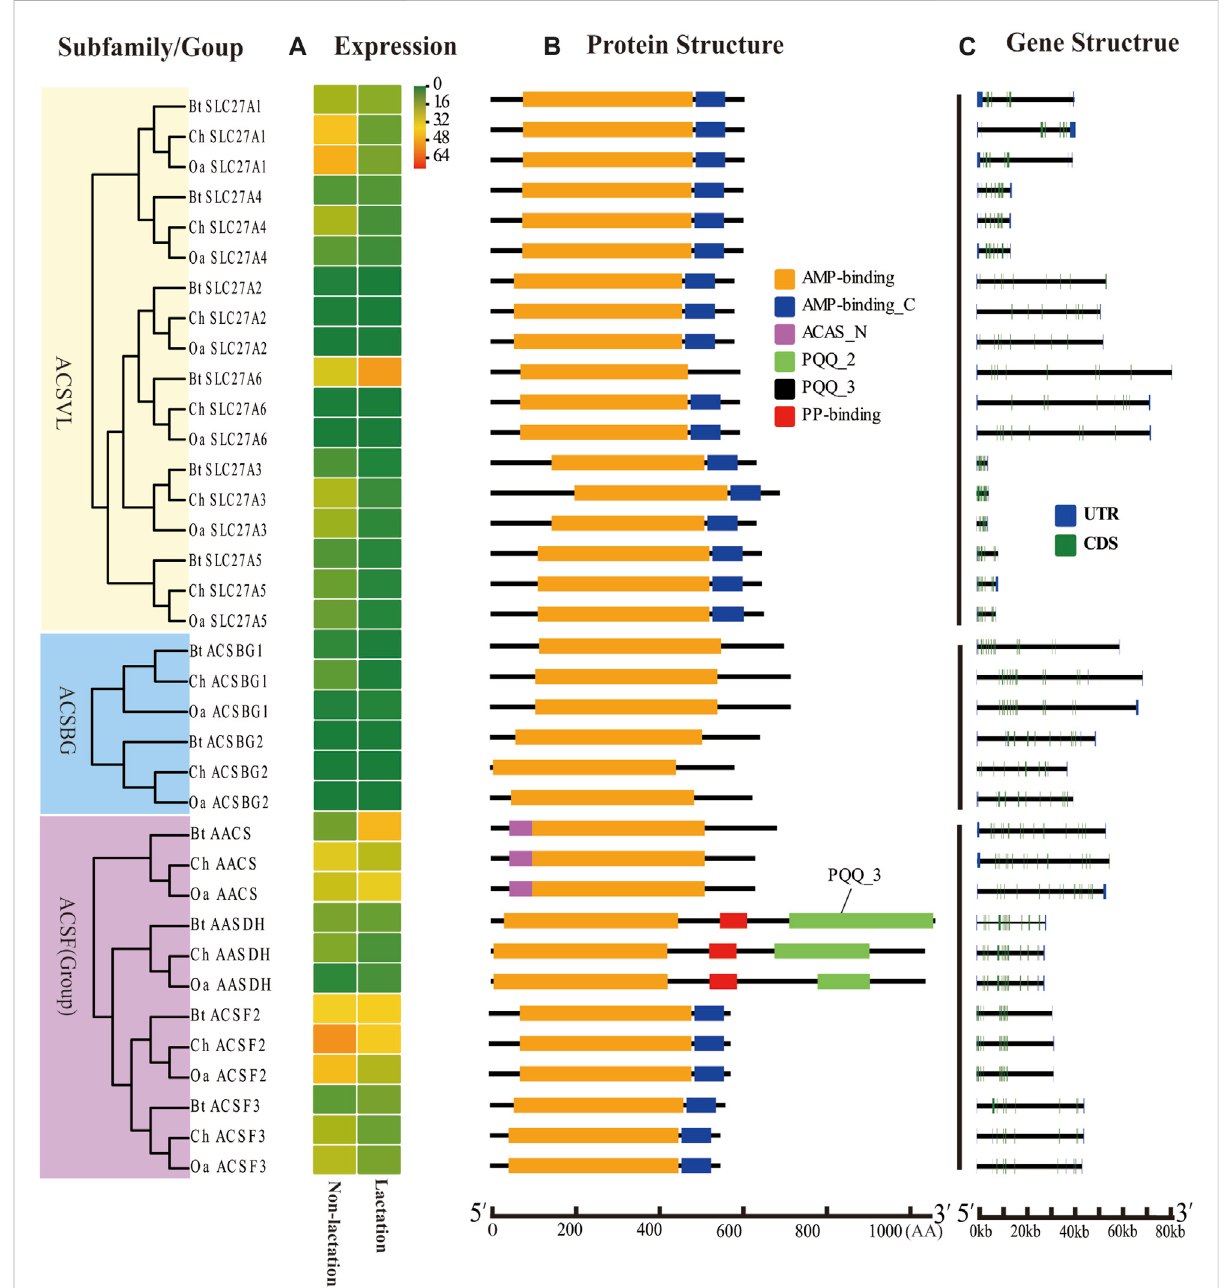
FIGURE 3 Expression pro fi les, gene structure, and protein structure of ACS genes from the ACSVL and ACSBG subfamilies and ACSF group. Legends: (A) Heatmapshowing theexpressionpro fi lesofACSgenesinthenon-lactation andlactation periodofthree species(dairygoat,sheep, andcow). Color gradient from green-to-red indicates expression values change from low to high. (B) Structures of ACS proteins with the AMP-binding domain represented by orange boxes, the AMP_C domain in red, ACAS_N domain in purple, PQQ_2 domainin green, PQQ_3 domain in black and PP- binding domain in red. (C) Structure of ACS genes with exons in green, UTR regions in blue, and solid lines between the colored boxes representing